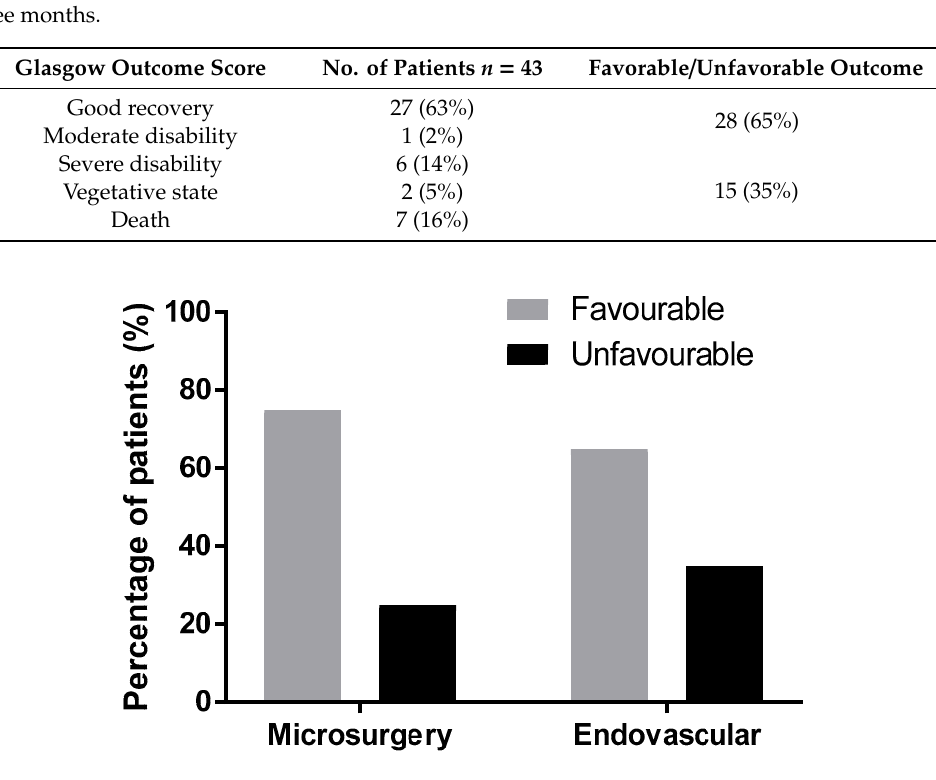
Table 3. Surgical treatment outcome of patients three months after subarachnoid hemorrhage (SAH) from ACoAA; GOS after three months.